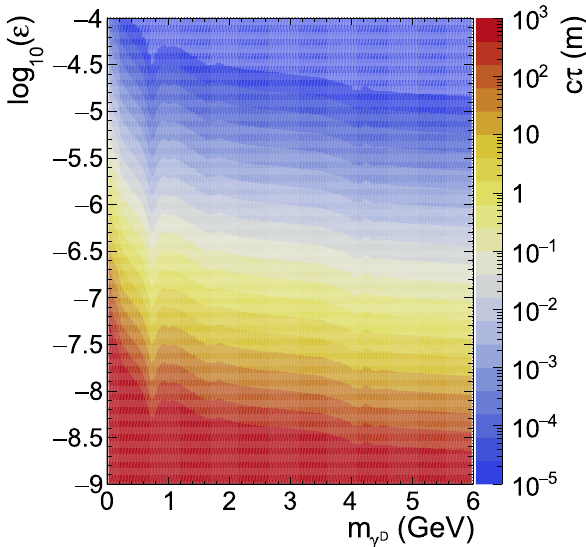
Fig. 9 Branching ratio to the visible decay channels, as a function of m γ D . Br (γ D → ch + ch ) is equal to 1 − Br (γ D → neutral